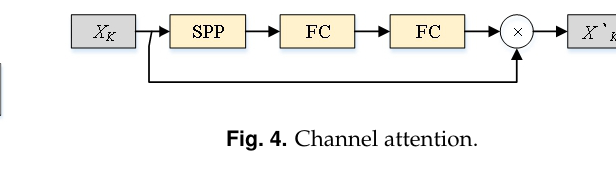
Fig. 3. CSAM attention mechanism module. Table 1. Comparison of time performance and performance with different superpixel methods.